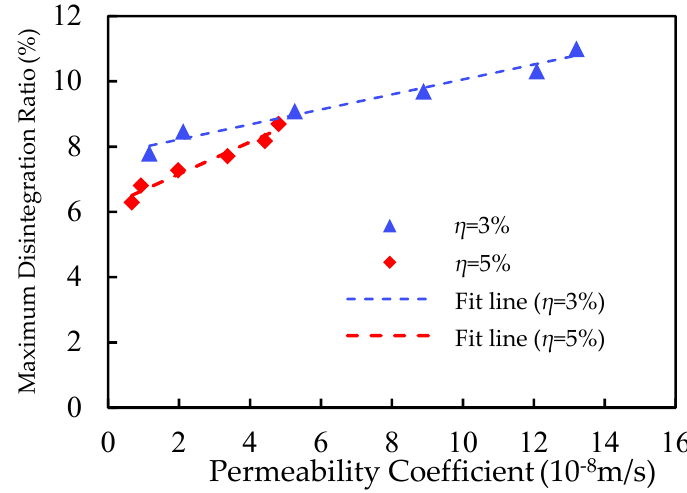
Figure 12. Variation of D m with permeability coefficient.